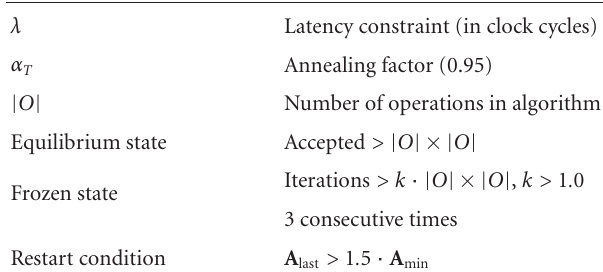
Table 1: Simulated annealing parameters and